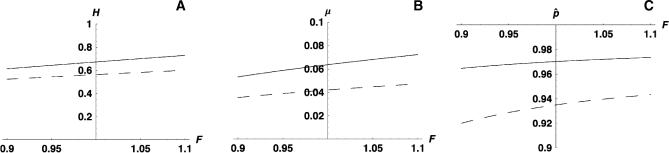
Effects of Changes in Parameters for Various Values of F
(A) Assuming μ = 0.04, the solid line shows the value of H needed to produce
p̂ = 0.90, and the dashed line shows the value of H needed to produce
p̂ = 0.94.
(B) Assuming H = 0.55, the solid line shows the value of μ needed to produce
p̂ = 0.90, and the dashed line shows the value of μ needed to produce
p̂ = 0.94.
(C) Assuming H = 0.55 and μ = 0.045 (dashed line) or μ = 0.0225 (solid line), this shows how
p̂ changes.